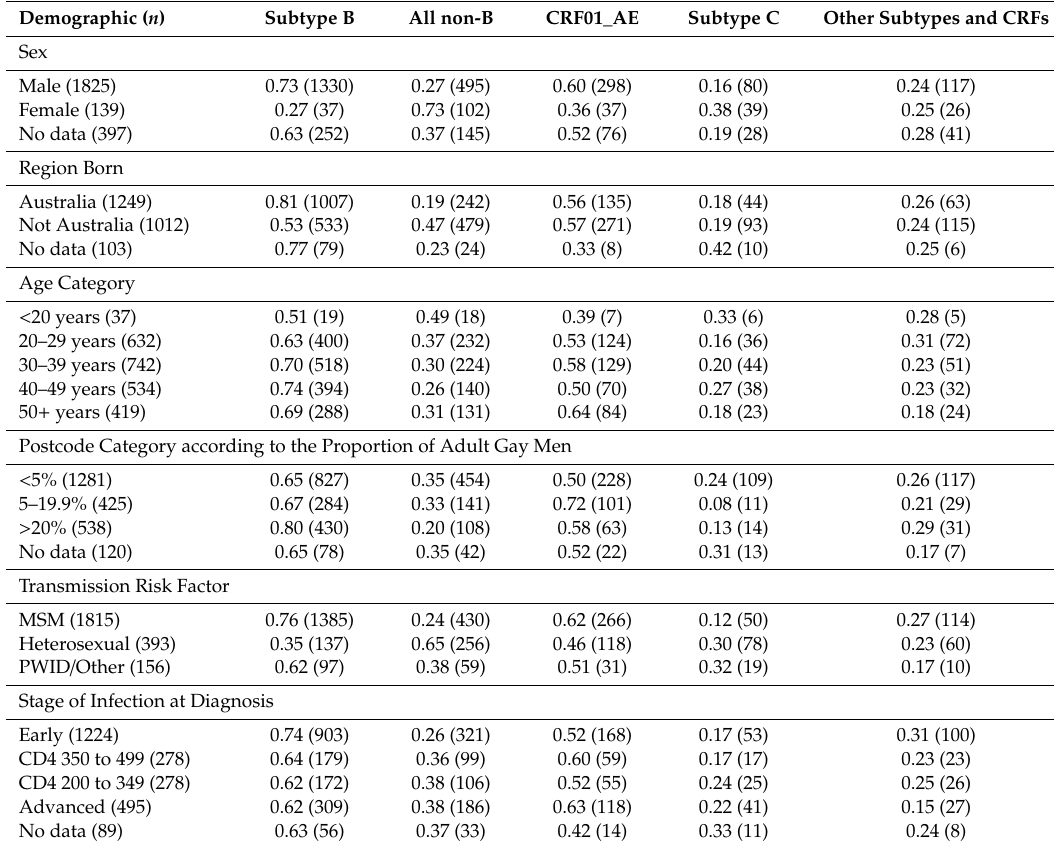
Table 1. Subtype-specific demographics. Proportion of infections associated with di ff erent demographics are shown for subtype B and all non-B subtypes, as well as individual non-B; subtype C, CRF01_AE and other subtypes and CRFs combined. Proportions are shown with the total number in brackets. Chi-square p values are shown in Figure